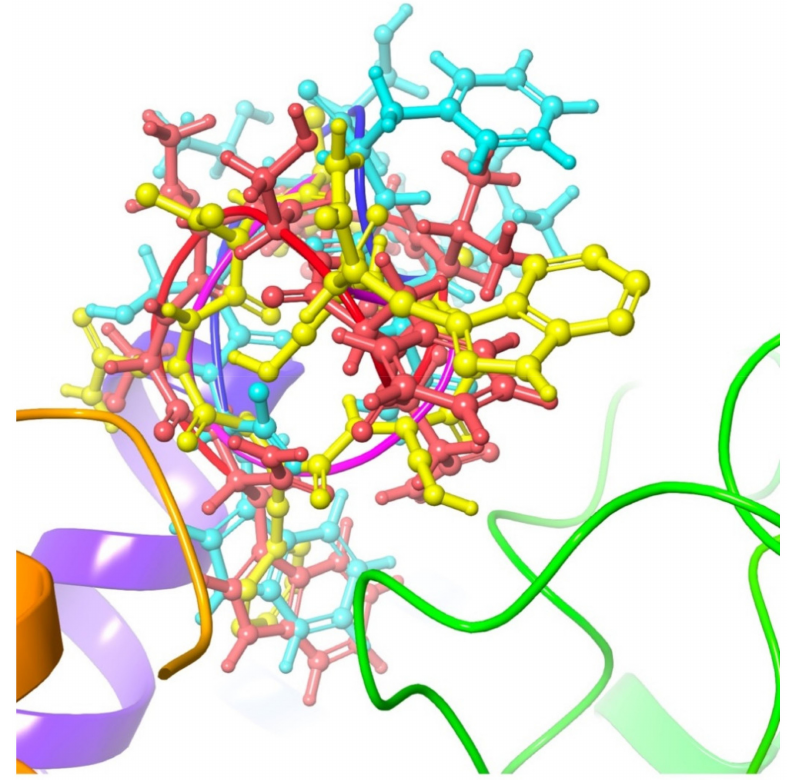
Figure 5. Overlay of Dappu-RPCH (red), Dappu-COOH (blue) and [Ace]Dappu (yellow) in the Dappu-RPCH R receptor binding